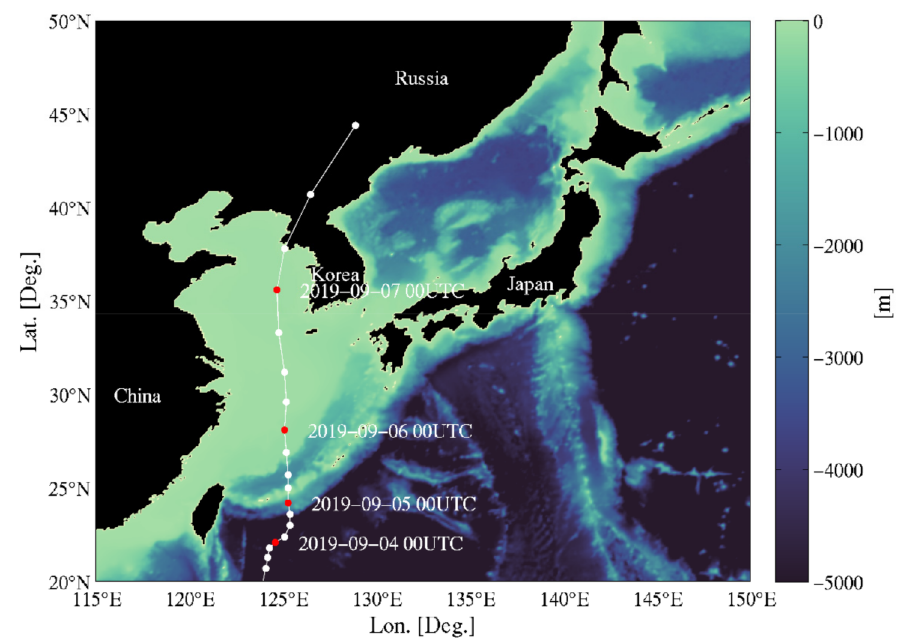
Figure 1. Ensemble wave model computational domain and Typhoon Lingling best track.